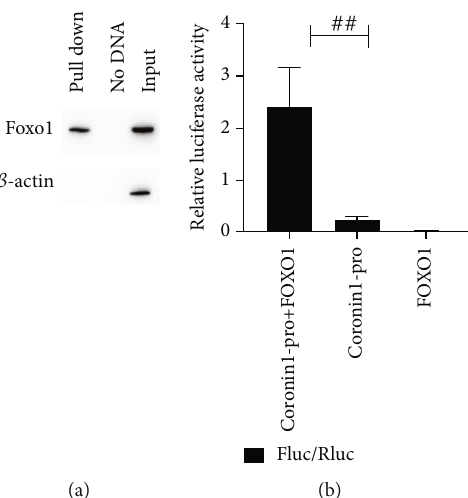
Figure 5: The transcription factor FOXO1 binds speci fi cally to the promoter region of coronin-1. (a) Western blotting analysis results of DNA pull down assay. (b) Relative luciferase activity of cotransfection of di ff erent plasmids. Coronin1-pro+FOXO1 represented cotransfection of pGL3-coronin1-pro-luc+ and pcDNA3.1(+)-FOXO1; coronin1-pro represented the cells just transfected by pGL3- coronin1-pro-luc; FOXO1 represented the cells just transfected by pcDNA3.1(+)-FOXO1. The signi fi cant di ff erences between relative luciferase activity of coronin1-pro+FOXO1 and coronin1-pro were marked by the pound sign. P values: ## P < 0 : 01